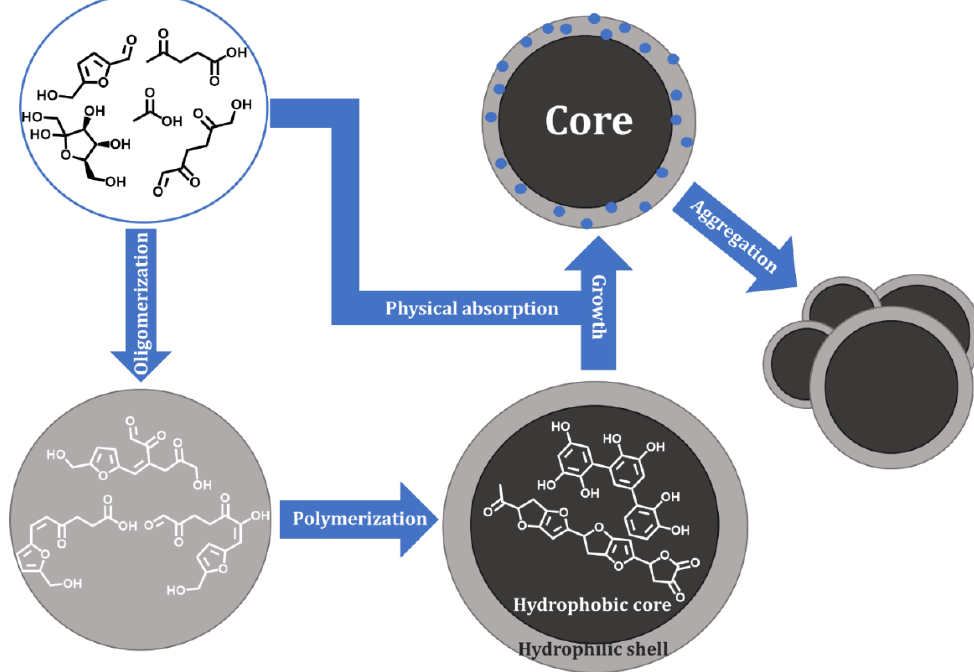
Figure 1. Process of humin formation from hexoses according to Siwei et al. [9].